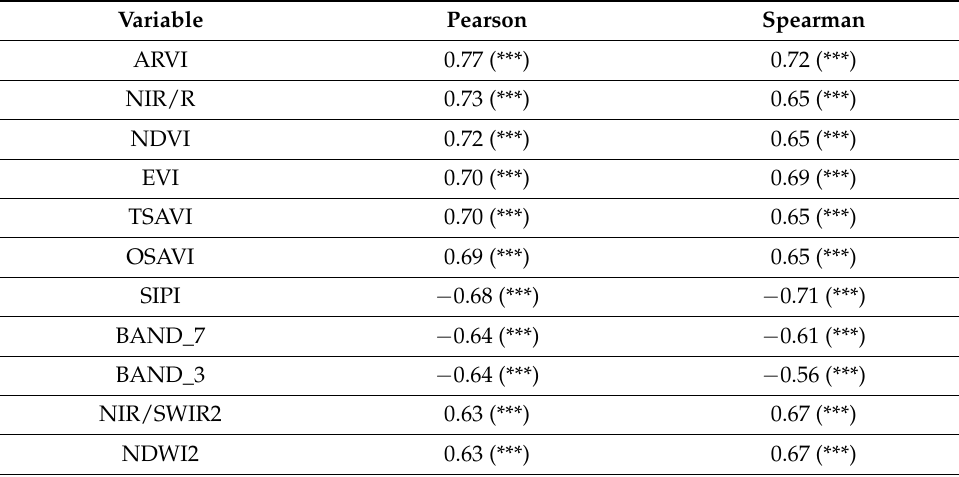
Table 2. Linear (Pearson) and monotonic (Spearman) correlation coefficients (R), p -value ( p ) and